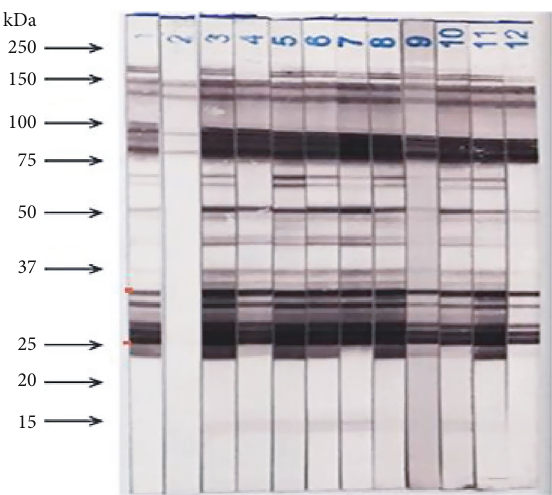
Figure 1: Protein bands detected by Western blotting that correspond to Toxocara canis antigens. Strips 1 and 2 were the positive and negative controls, respectively, while strips 3 to 12 represent positive serum samples. Table 2: ELISA reaction results to Toxocara canis and helminth antigens. Helminth antigens Sample no.